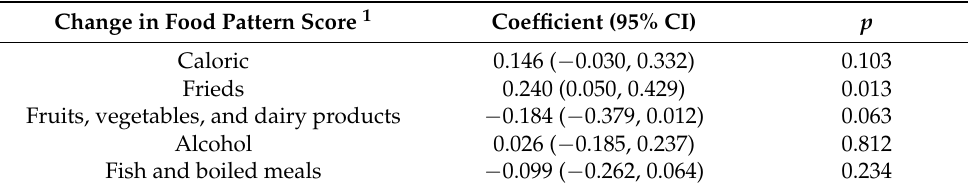
Table 6. Relation between baseline to 6-month changes in dietary pattern scores and body weight using the entire sample independent of group allocation (intention-to-treat data